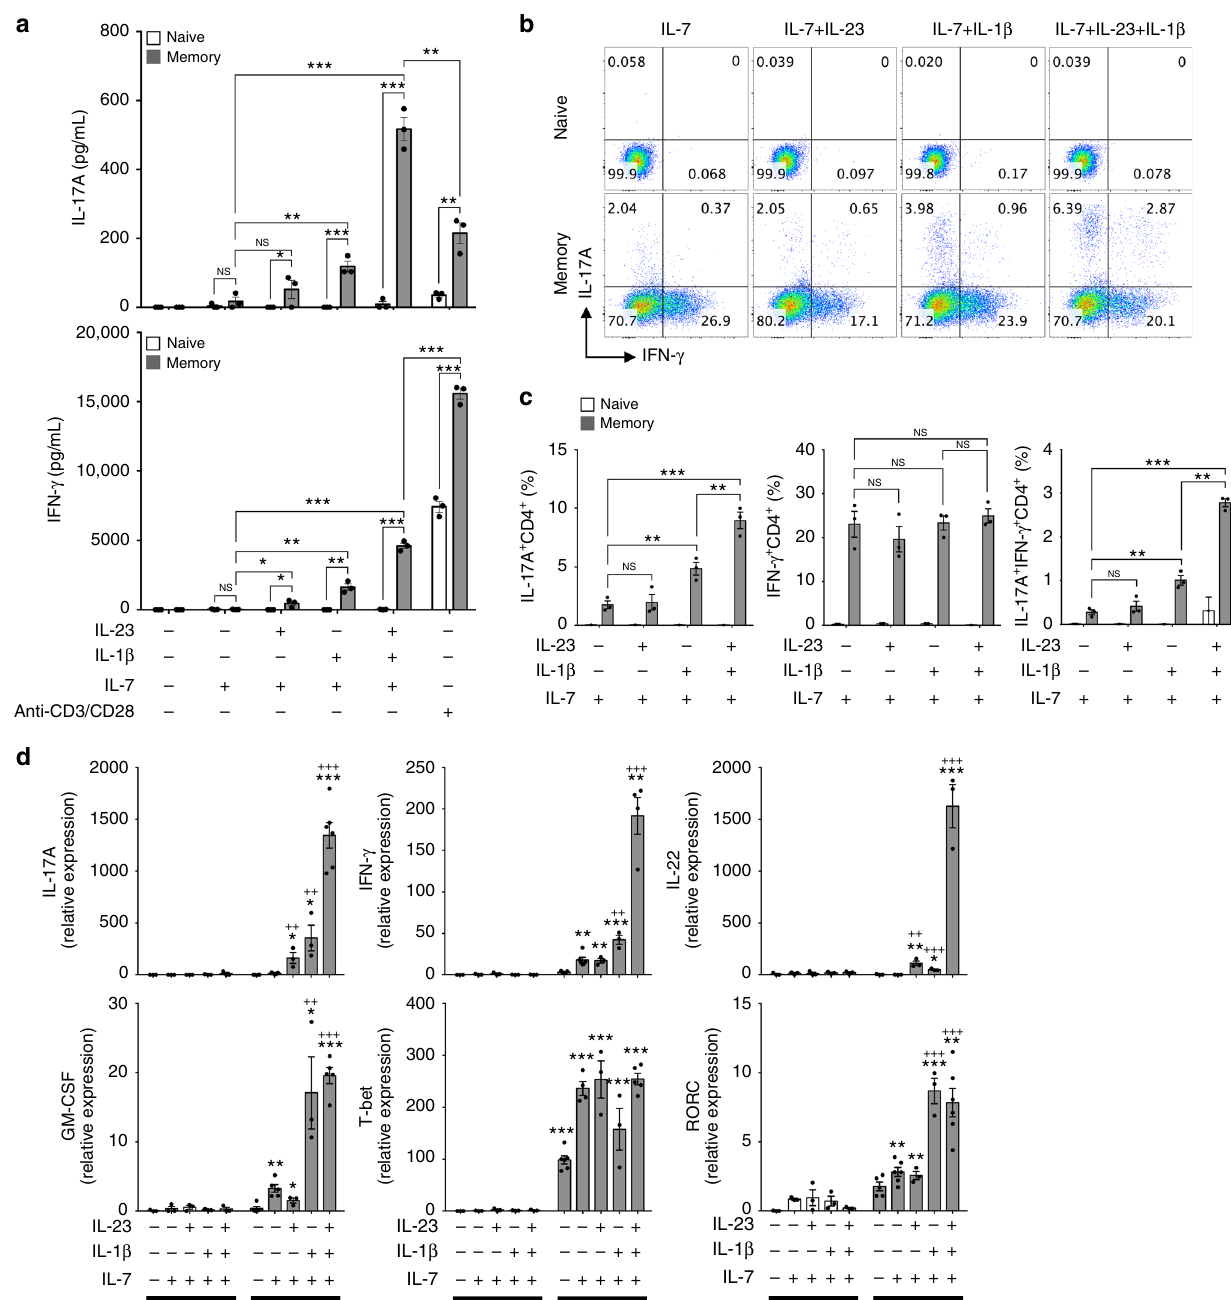
Fig. 1 Memory-like CD4 + T cells respond to IL-1 β and IL-23 by producing IL-17A and IFN- γ in the absence of TCR engagement. Naive (CD4 + CD25 − CD62L high CD44 low ) and memory-like (CD4 + CD25 - CD62L low CD44 high ) T cells were stimulated with IL-1 β and/or IL-23 in the presence of IL-7 or anti- CD3/CD28 for 5 days. a IL-17A and IFN- γ concentrations in the supernatants were measured by ELISA. b , c The frequencies of IL-17A and IFN- γ -producing cells were analyzed by fl ow cytometry. d mRNA levels of transcription factors and cytokines were analyzed by quantitative real-time PCR. * p < 0.05, ** p < 0.01, *** p < 0.001 versus naive CD4 + T cells plus IL-7; + p < 0.05, ++ p < 0.01, +++ p < 0.001 versus memory-like CD4 + T cells plus IL-7. Data are presented as the mean ± SEM of at least three independent